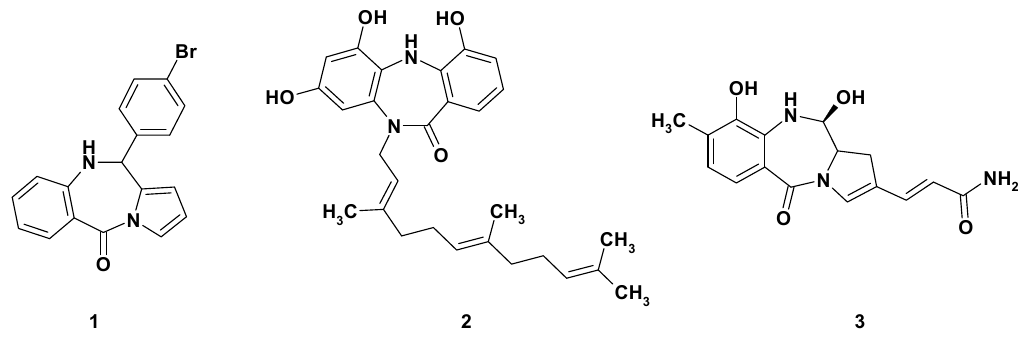
Figure 1. Representatives of tricyclic benzodiazepine derivatives exhibiting anticancer activity.